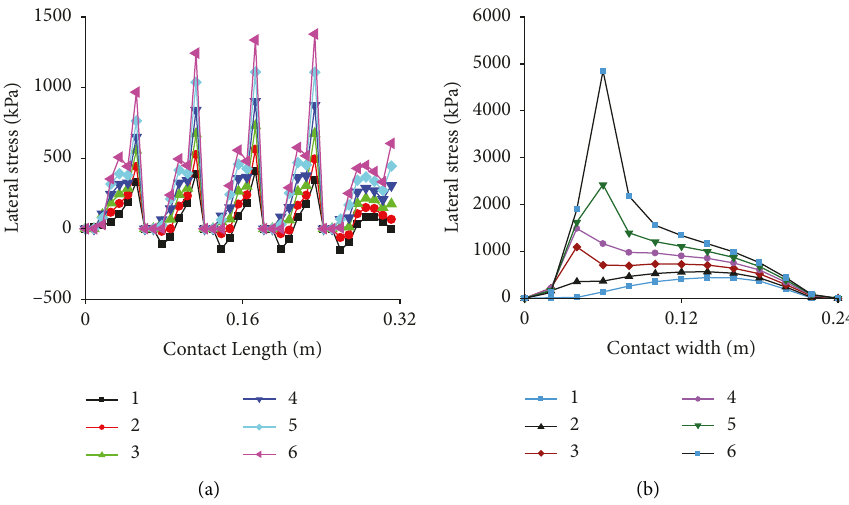
Figure 20: Lateral stress under different slip angles: (a) width and (b)